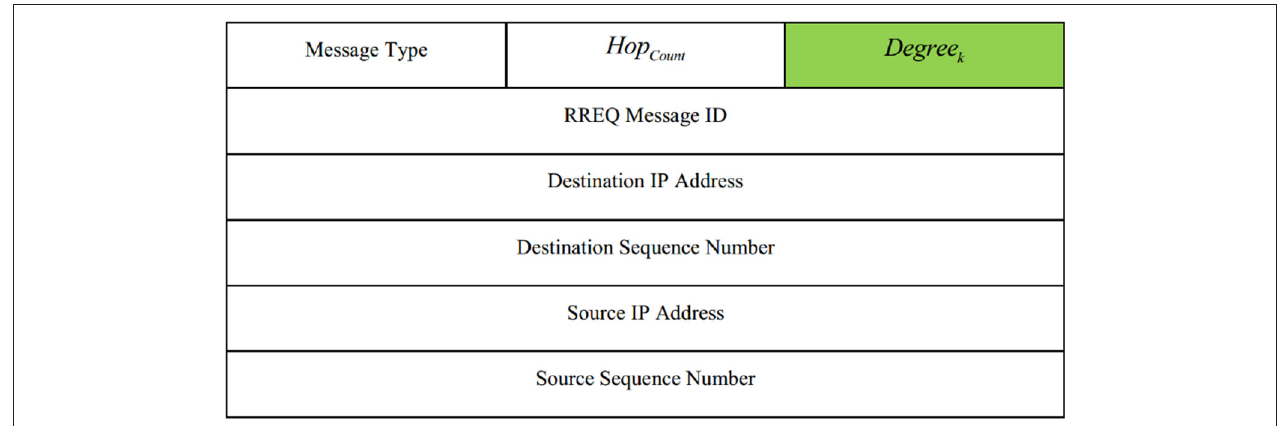
FIGURE 4 | RREQ packet